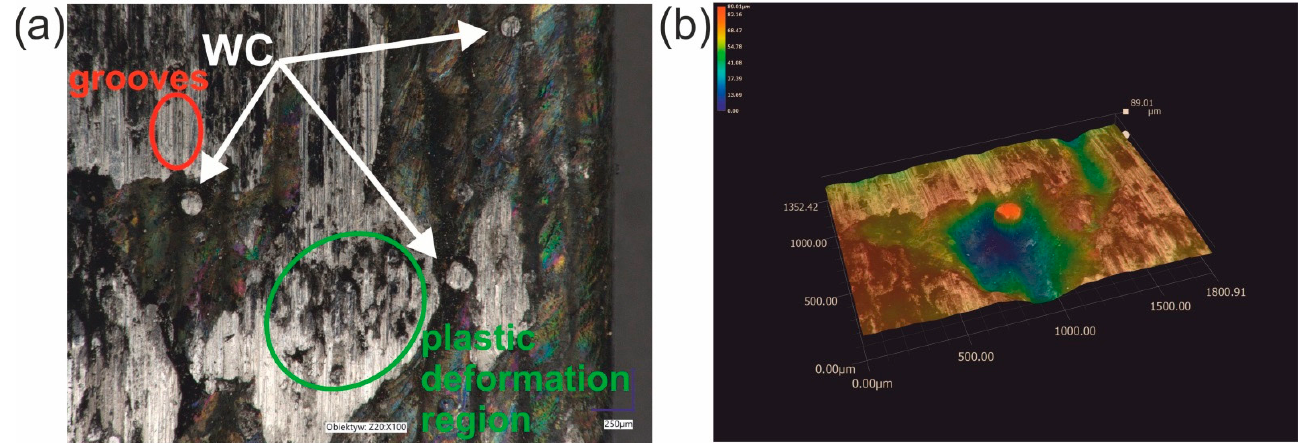
Figure 15. The surface morphology of the specimen laser-alloyed with a laser beam power of 1.3 kW after the wear resistance test: ( a ) image recorded by the digital microscope, ( b ) 3D image of the surface topography; the arrows indicate WC particles.